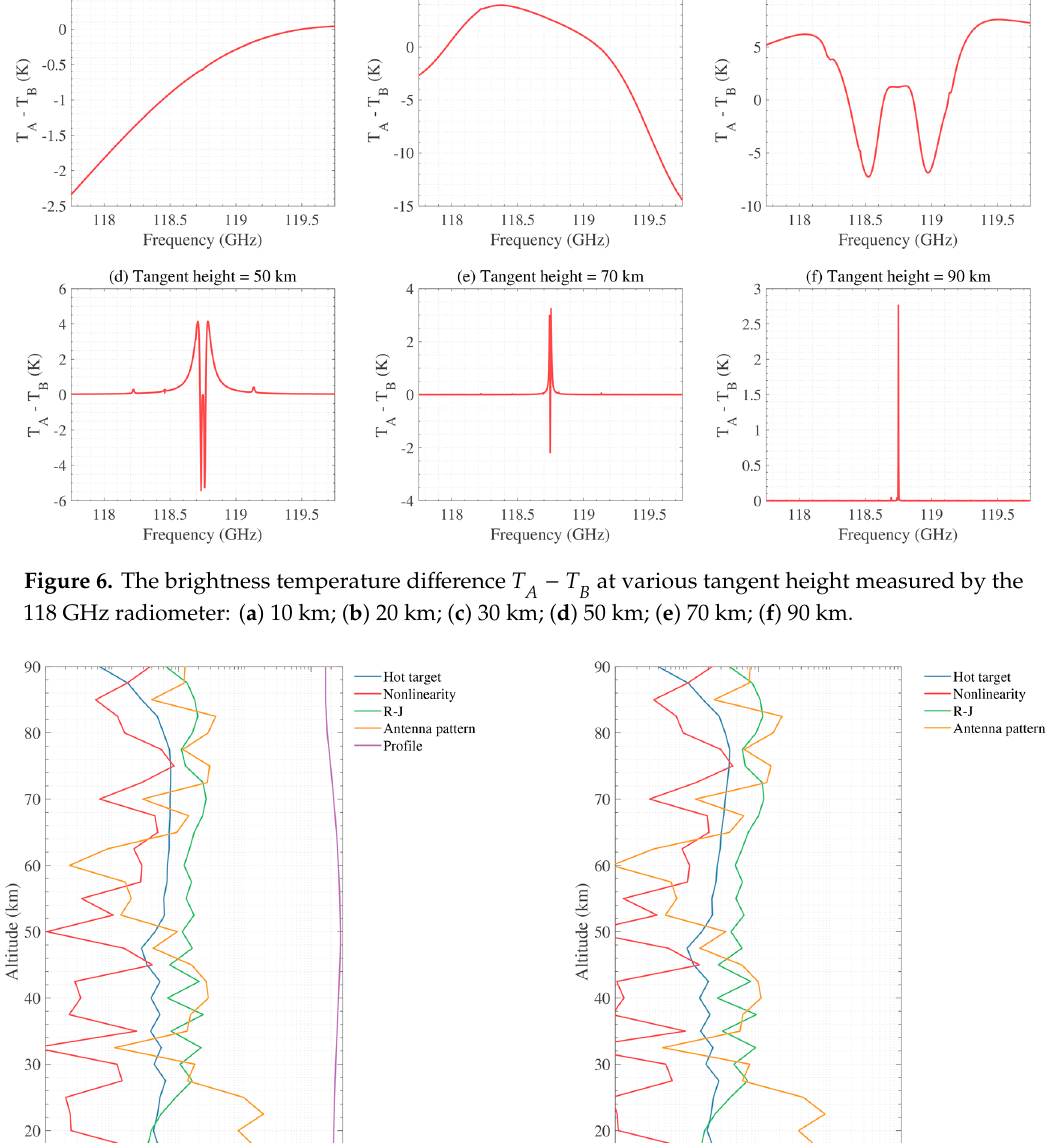
Figure 8. The temperature retrieval errors induced by external error sources: ( a ) absolute and ( b ) relative retrieval errors. The uncertainties assumed are summarized in Table 5.